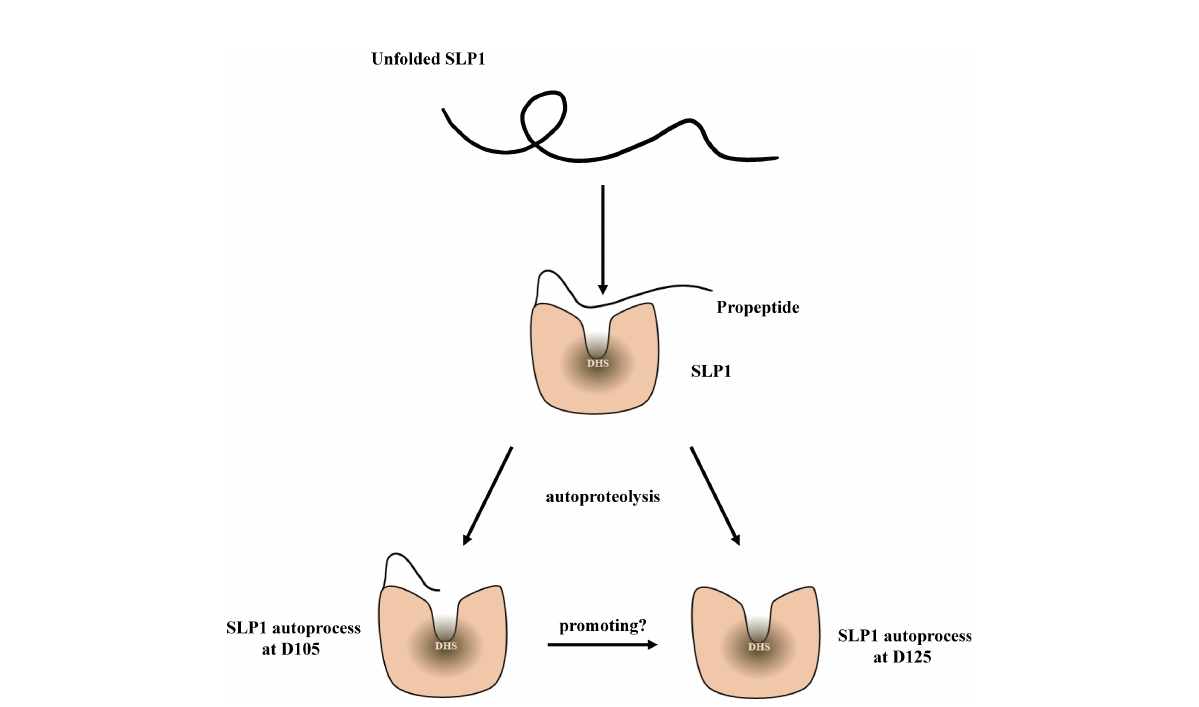
FIGURE 6 Model of NbSLP1 autoproteolysis. Functional structure of NbSLP1 was constructed correctly with its propeptide; After signal peptide cleavage, at least twice auto-cleavage were observed at Asp 105 and Asp 125 , respectively, leading to two hypotheses about autoproteolysis of NbSLP1. SLP1 can cleave at Asp 105 and Asp 125 at the same time, or SLP1 cleavage itself at Asp 105 (D105) fi rstly, and this structure promote the second cleavage at Asp 125